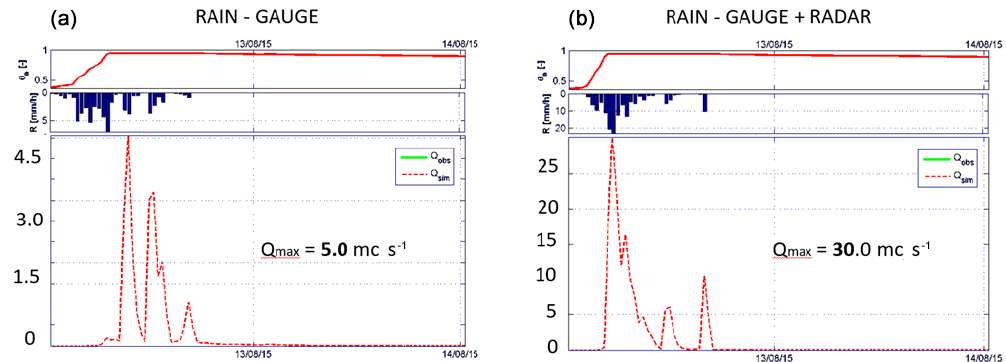
Figure 4. The hydrological response of the Fosso Pantano basin using rain gauge alone (a) and radar with rain-gauge data (b)